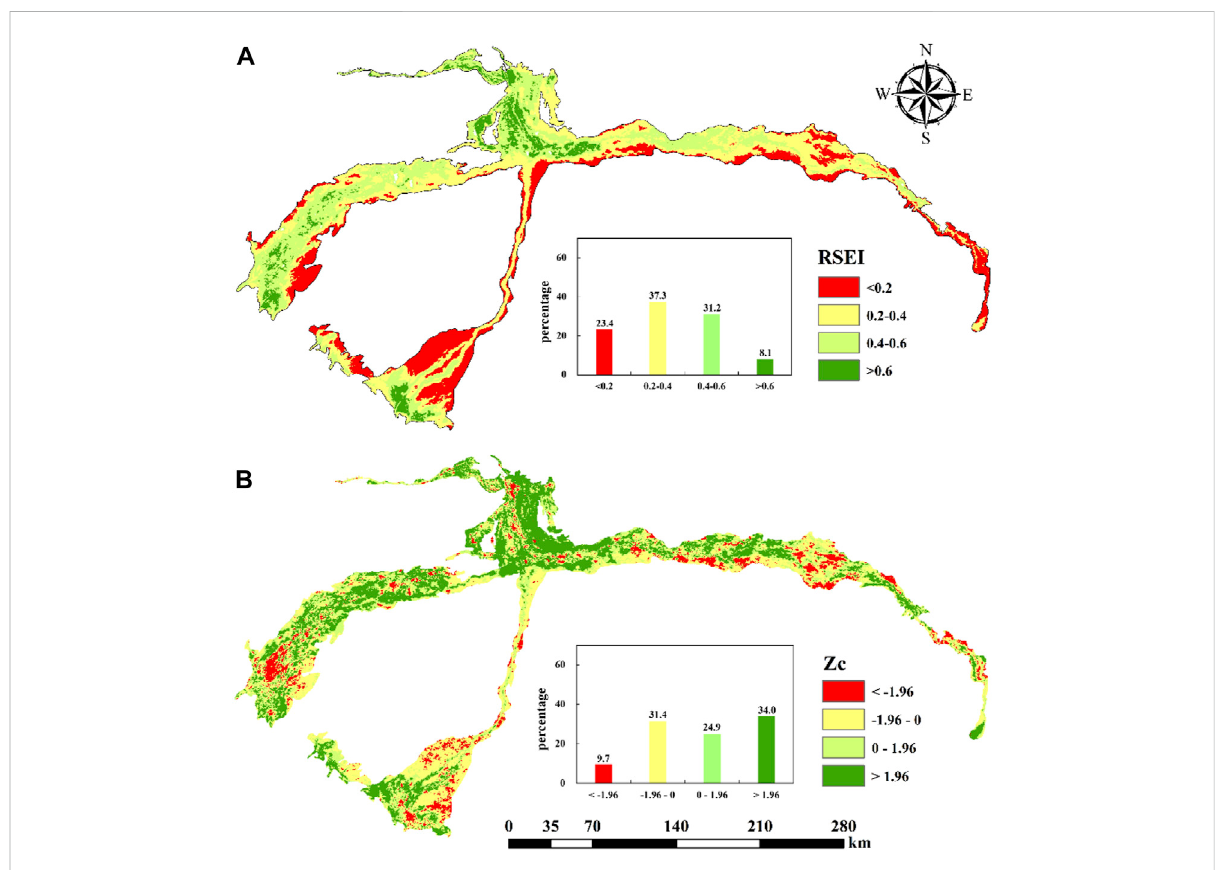
FIGURE 6 Spatial distribution (A) of annual average RSEI and spatial distribution (B) of RSEI variation trend in Tarim River Basin from 2000 to 2021.